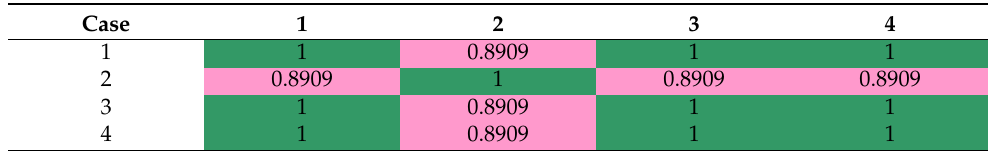
Table 10. Values for the criteria by a different